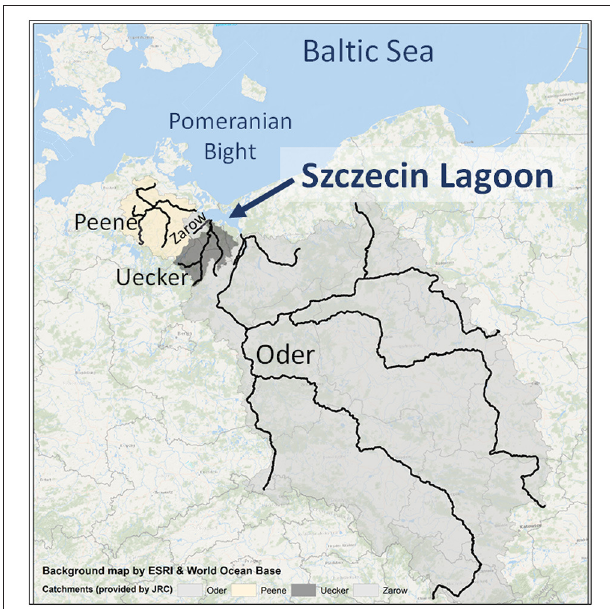
FIGURE 1 | Catchment areas of the main rivers entering Szczecin Lagoon.